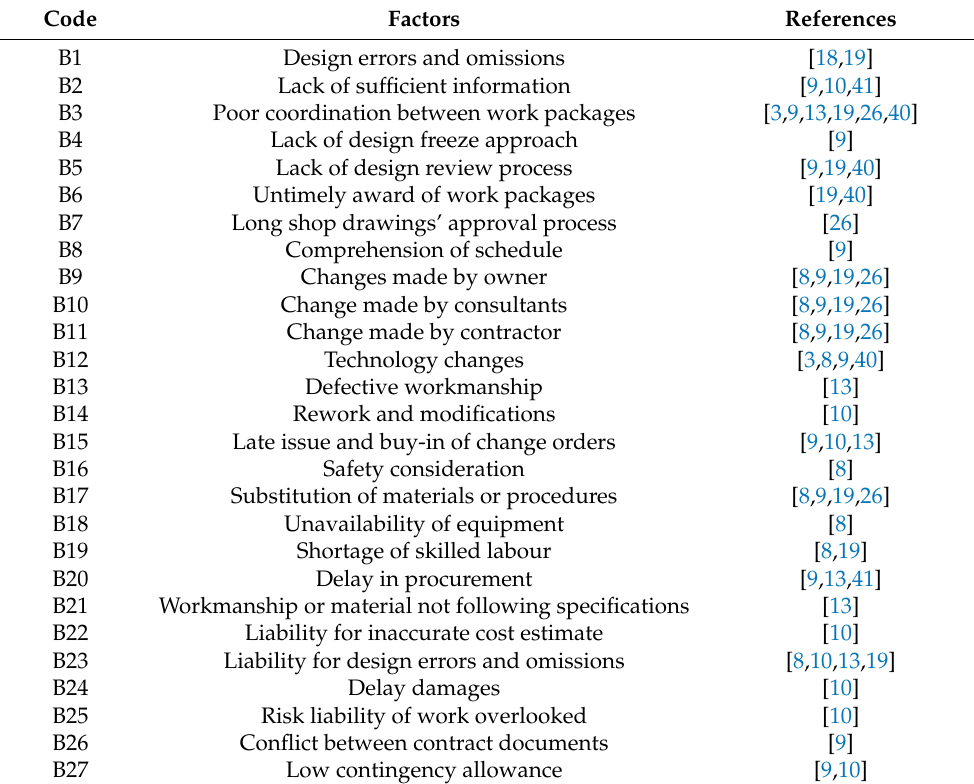
Table 1. Barriers impacting the success of fast-track projects.